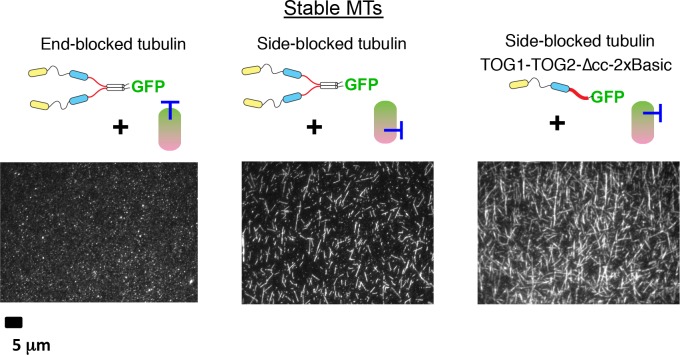
Additional data from assays using mutated tubulins.More experiments testing whether tubulin mutated on the lateral or longitudinal tubulin interfaces can antagonize interactions between the basic region and the microtubule. Results are consistent with Figure 5 in showing that lateral interactions between TOG-bound tubulins are important: lattice binding by Stu2 is attenuated in the presence of plus-end blocked tubulin (β-tubulin:T175R,V179R, left); lattice binding by dimeric or monomeric forms of Stu2 is not attenuated in the presence of a mutation on the lateral interface (α-tubulin:H284A, middle and right). Samples contain 100 nM Stu2-eGFP variant and 1 μM tubulin mutant; unlabeled, GTPγS-stabilized yeast microtubules were used as the MT binding substrate.